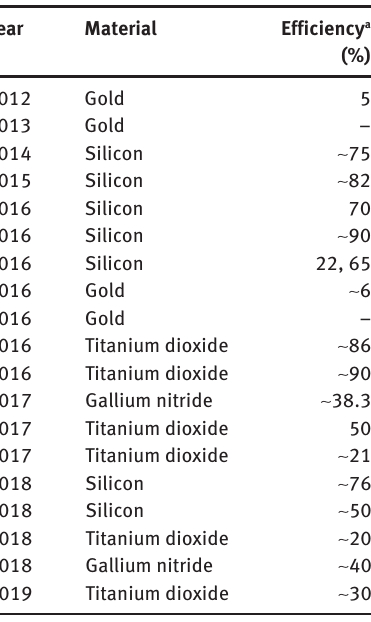
Table 2: Conclusive table on